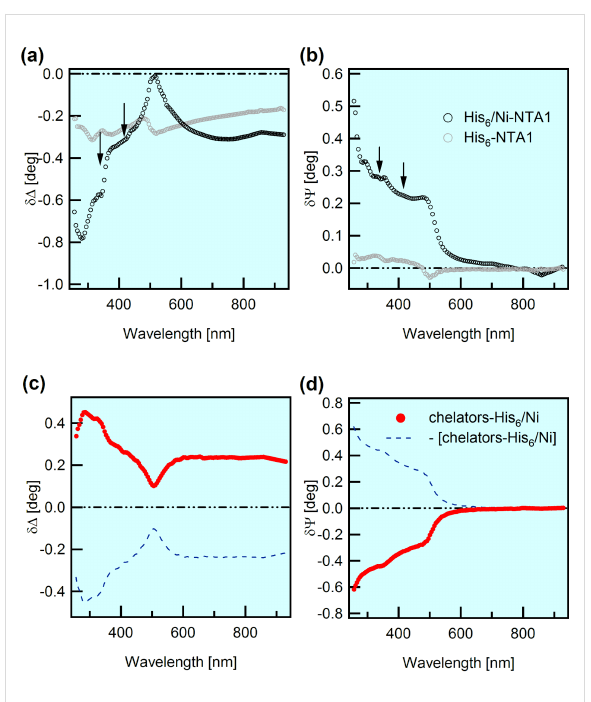
Figure 4: His 6 adsorption on the NTA/Au system and subsequent treatment with imidazole/EDTA. The SE data are derived from in situ (buffer) measurements at 65° angle of incidence. (a,b) δΔ 2,1 and δΨ 2,1 difference spectra; the suffixes 1 and 2 indicate the NTA1/Au system before and after the exposure to His 6 molecules, respectively. Black and light grey symbols refer to measurements with and without Ni(II) loading, respectively. Arrows indicate possible weak optical absorp- tions (see the text for details). (c,d) Red symbols: , spec- tra; the suffixes 1’ and 2 stand for the His 6 /NTA1/Au system after and before the treatment with chelating agents. The blue dashed curves represent and